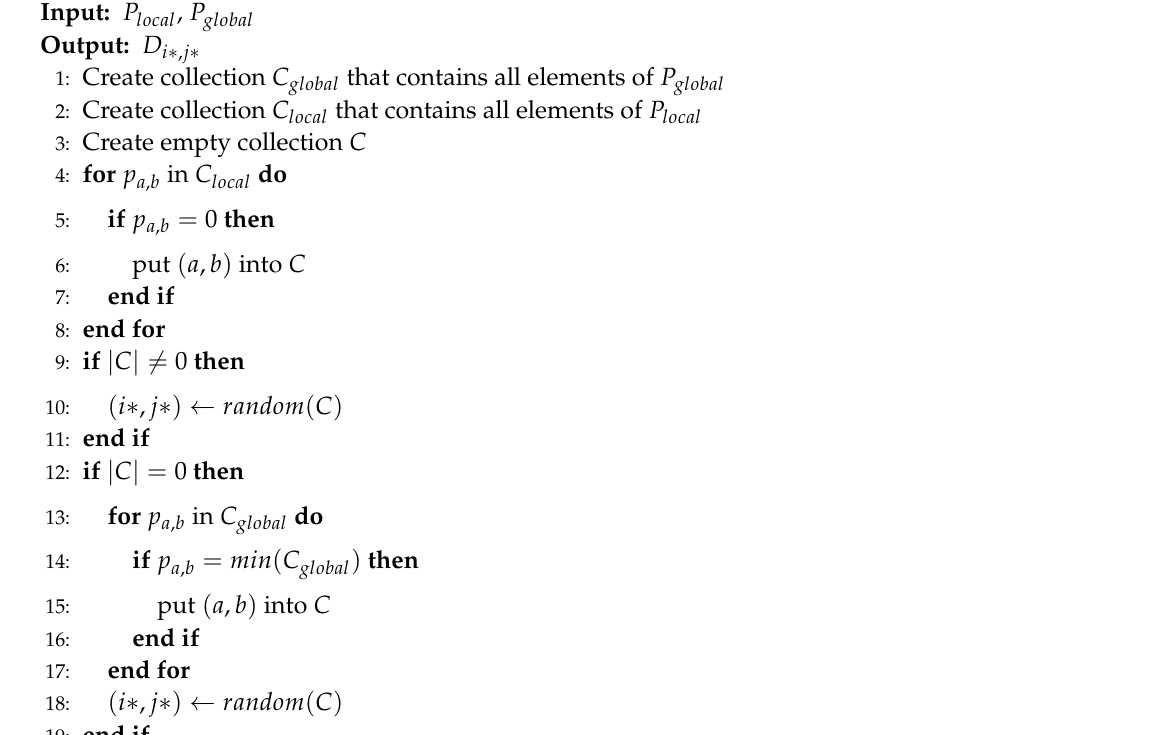
Algorithm 4 Get the next cell to visit according to pheromone